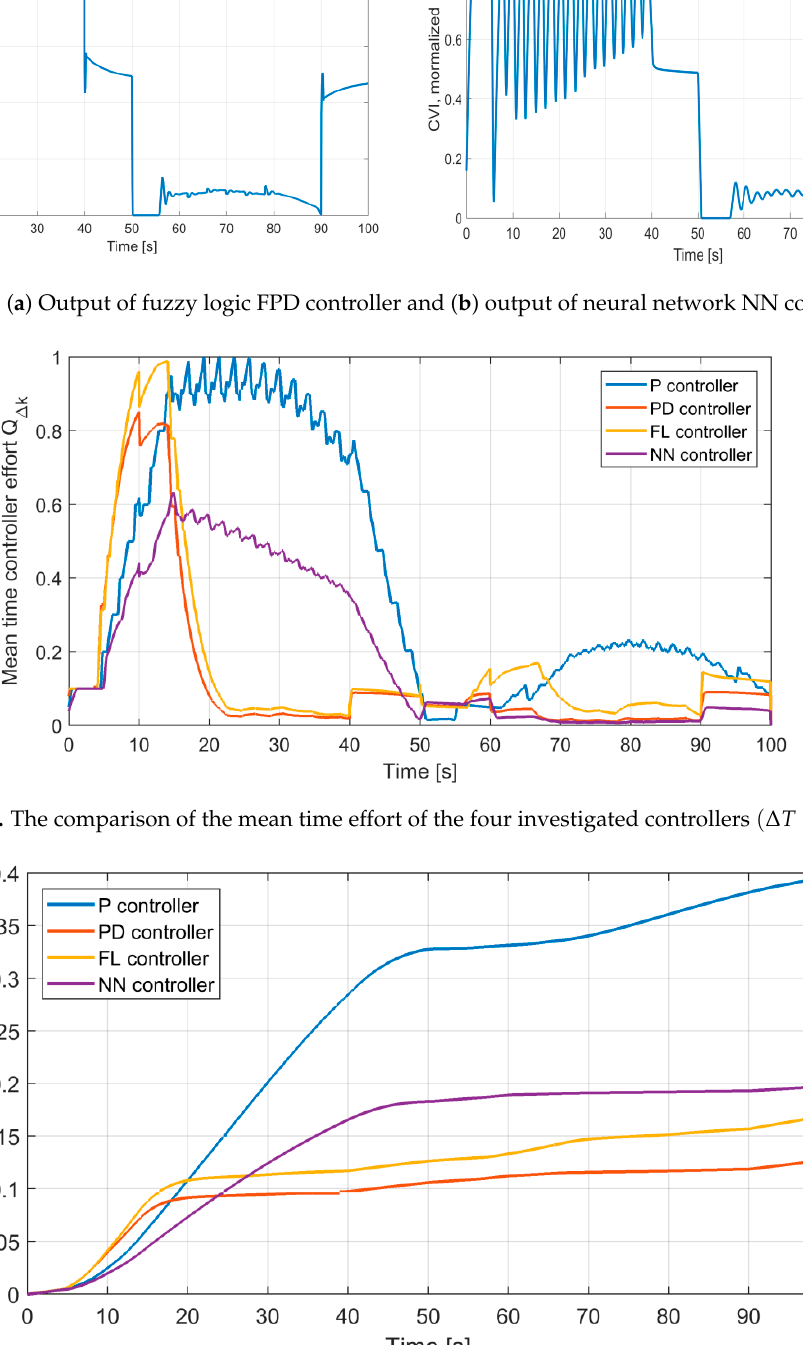
Figure 15. ( a ) Output of fuzzy logic FPD controller and ( b ) output of neural network NN controller.